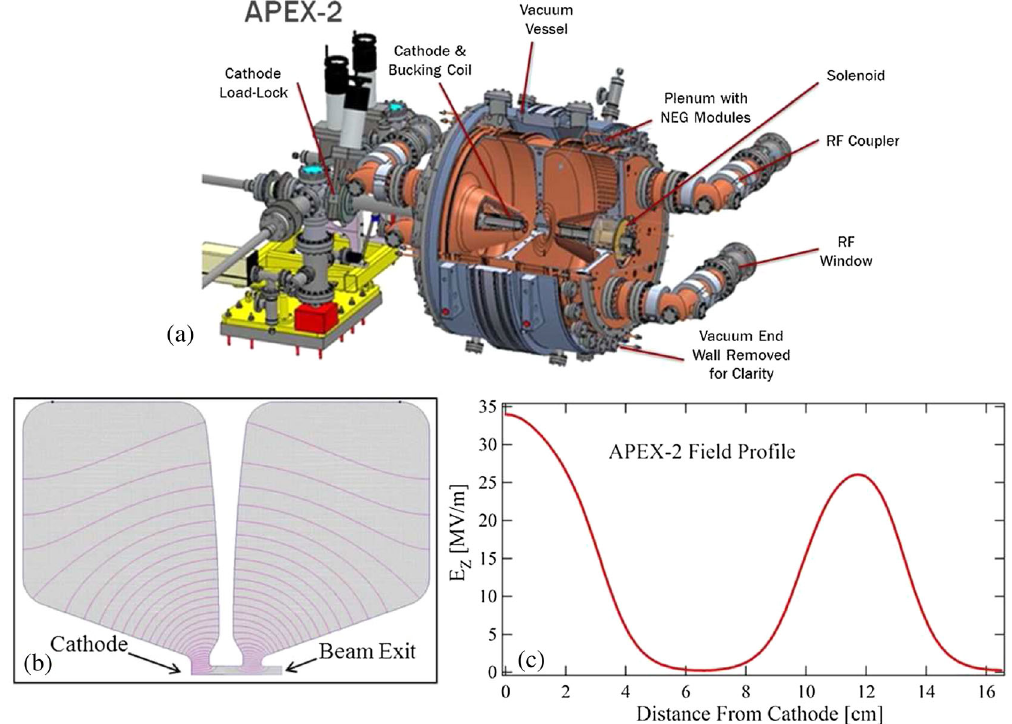
FIG. 2. (a) 3D CAD view of a double-cell version of APEX and of its main parts. (b) Electric field distribution inside the cells. (c) Longitudinal electric field intensity along the longitudinal axis of the